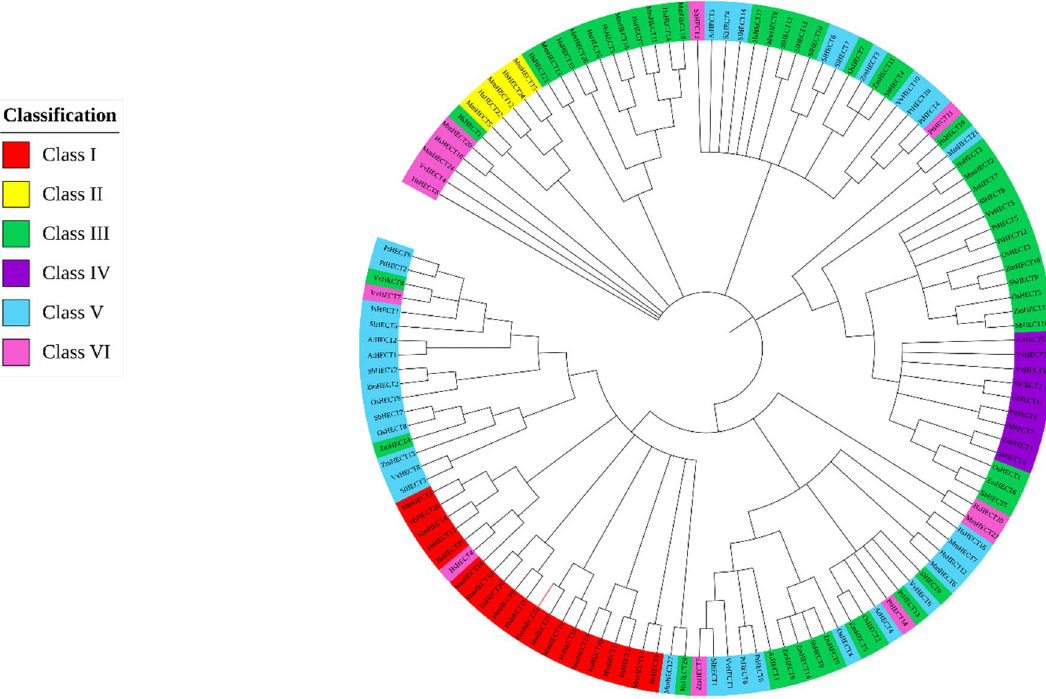
Figure 1. The phylogenetic tree representing the HECT E3 ubiquitin ligase members of Solanum lycopersicum , Oryza sativa , Arabidopsis thaliana , Populus trichocarpa, Vitis vinifera, Sorghum bicolor, Zea mays, Mus musculus , and Homo sapiens constructed by Neighbour-Joining (NJ) method with 1000 bootstrap values. The HECT gene family is sub-divided into six classes, represented by different colors (Supplementary Table S3 and Supplementary Figure